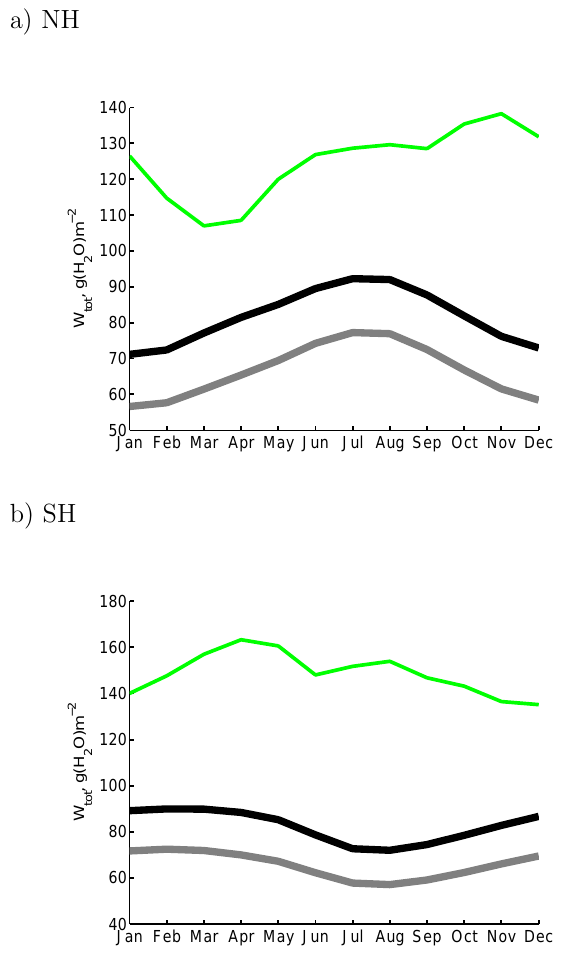
Fig. 6. Cloud water path ( g(H 2 O)m − 2 ) averaged over the Northern and Southern Hemispheres ( a and b respectively) for the model with initial and calibrated parameter sets (gray and black lines correspondingly) as well as for the CERES data set (green).